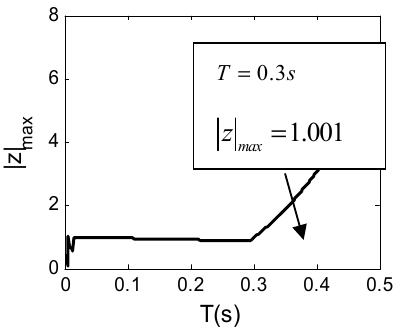
Figure 4. Maximum module max z of the poles vs. the task scheduling period T .